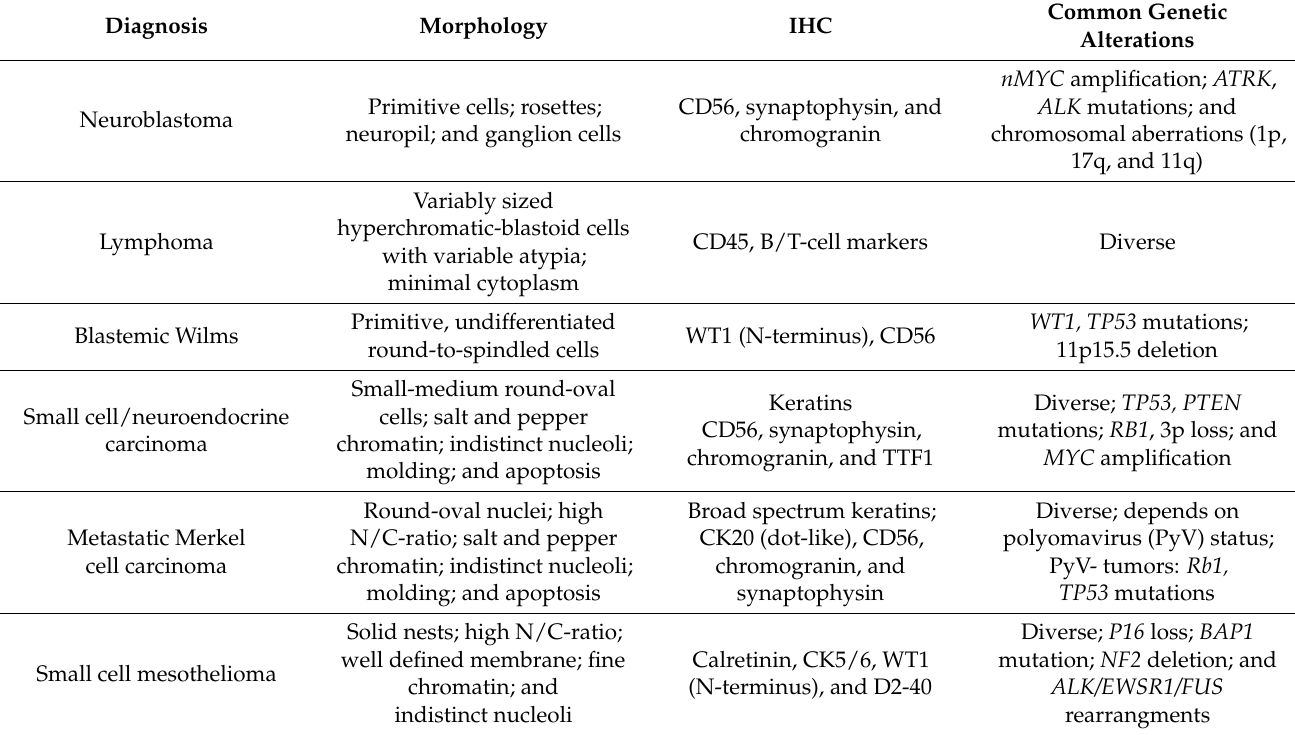
Table 3. Differential diagnoses of DSRCT (except small blue round-cell sarcoma; see Ewing). Diagnosis